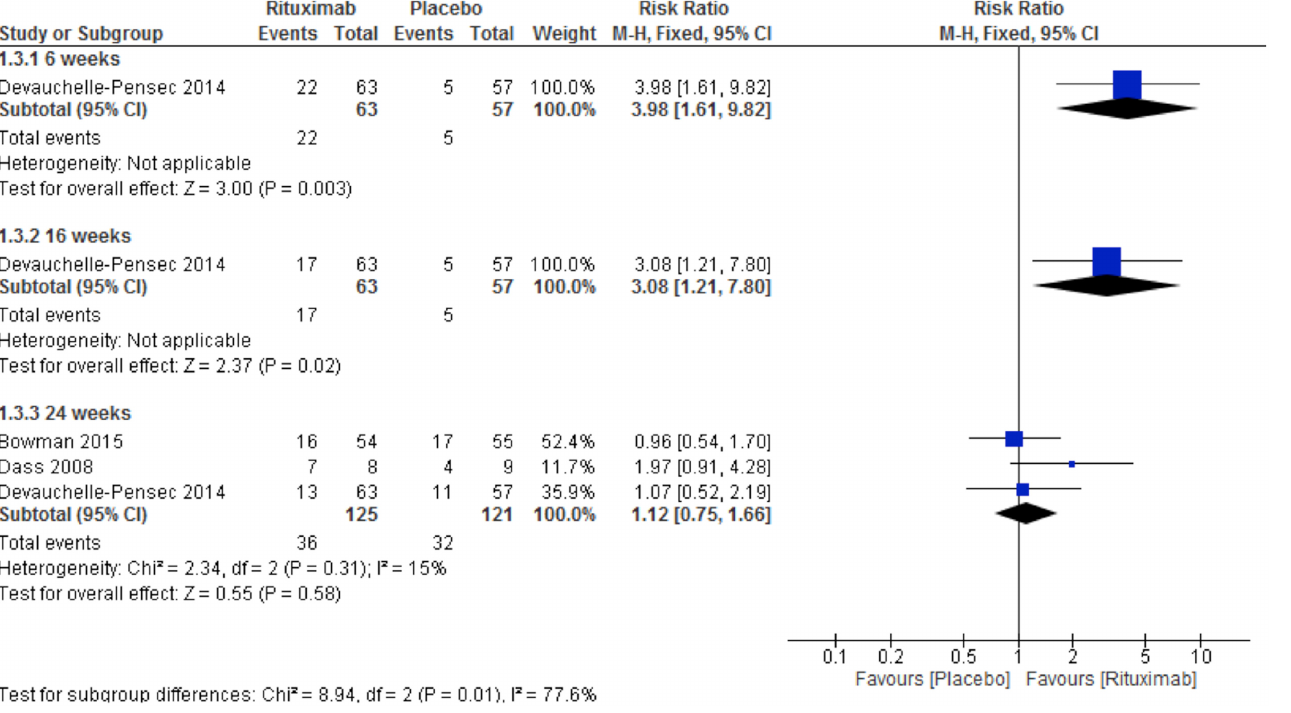
Fig 6. Rituximab X Placebo. Meta-analysis of the outcome fatigue VAS 30% improvement at week 24.